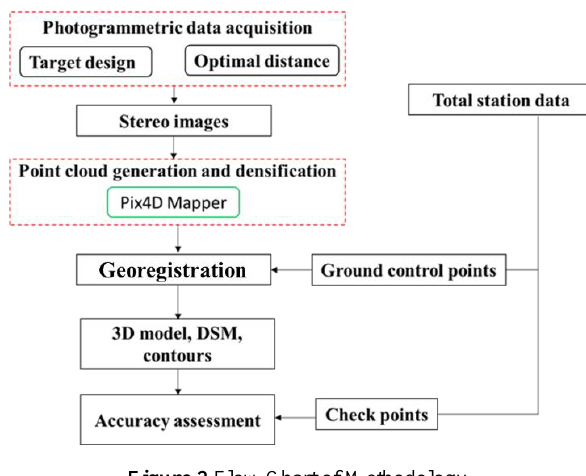
Figure 2 Flow Chart of Methodology